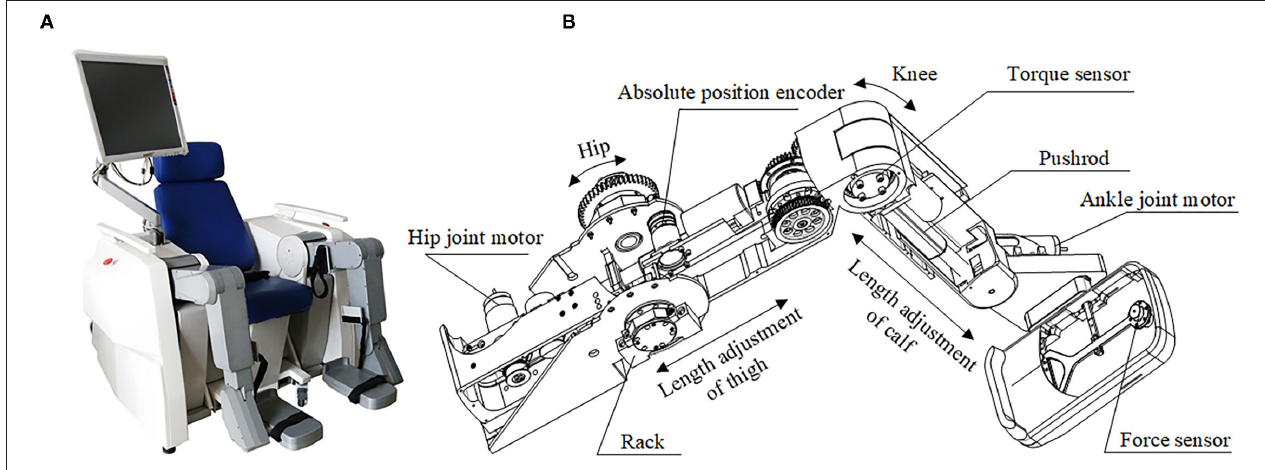
FIGURE 10 | Setting up the experimental scene. (A) Experimental arrangement in the sagittal plane; (B) Experimental arrangement in the coronal plane.